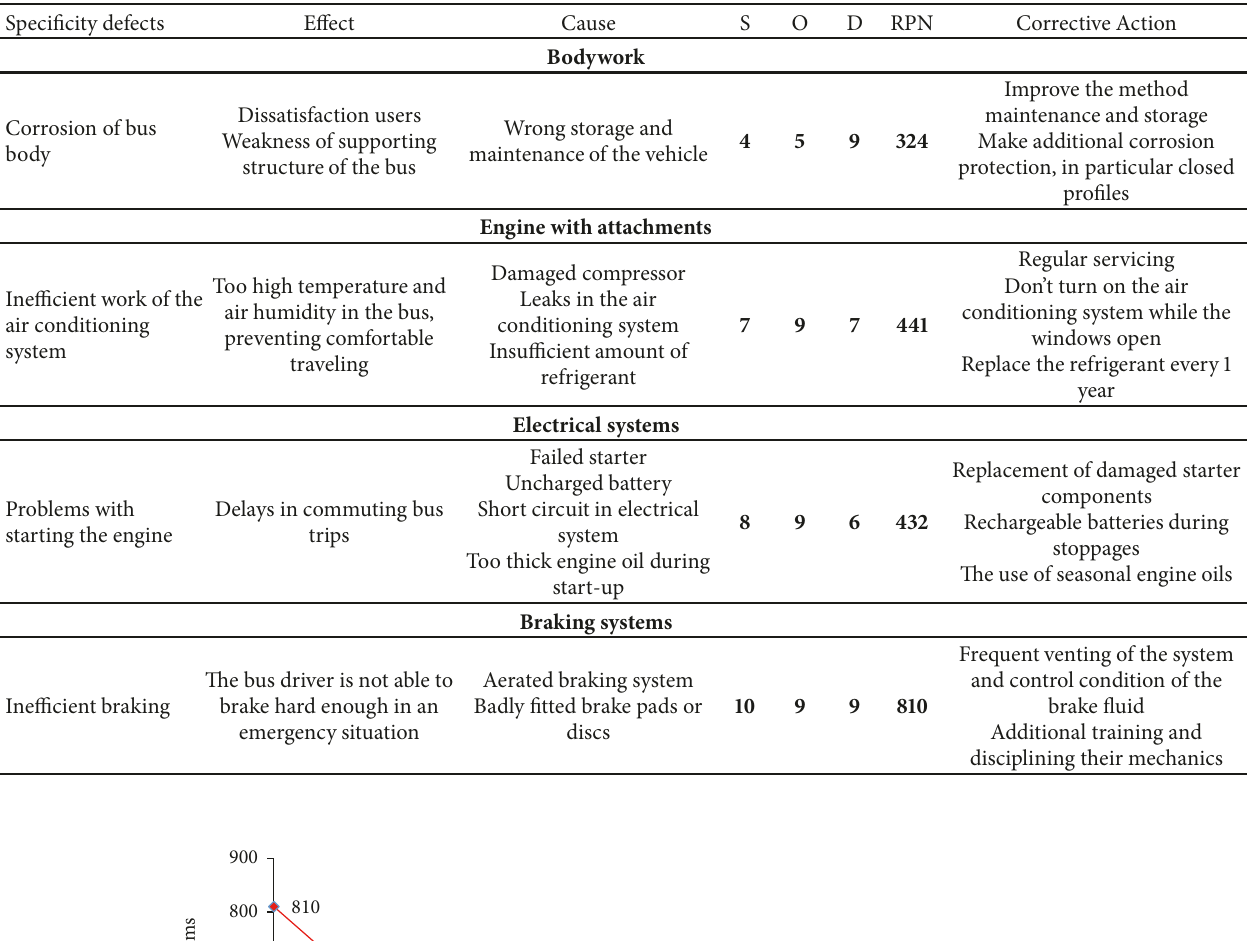
Table 6: First FMEA analysis for individual systems.